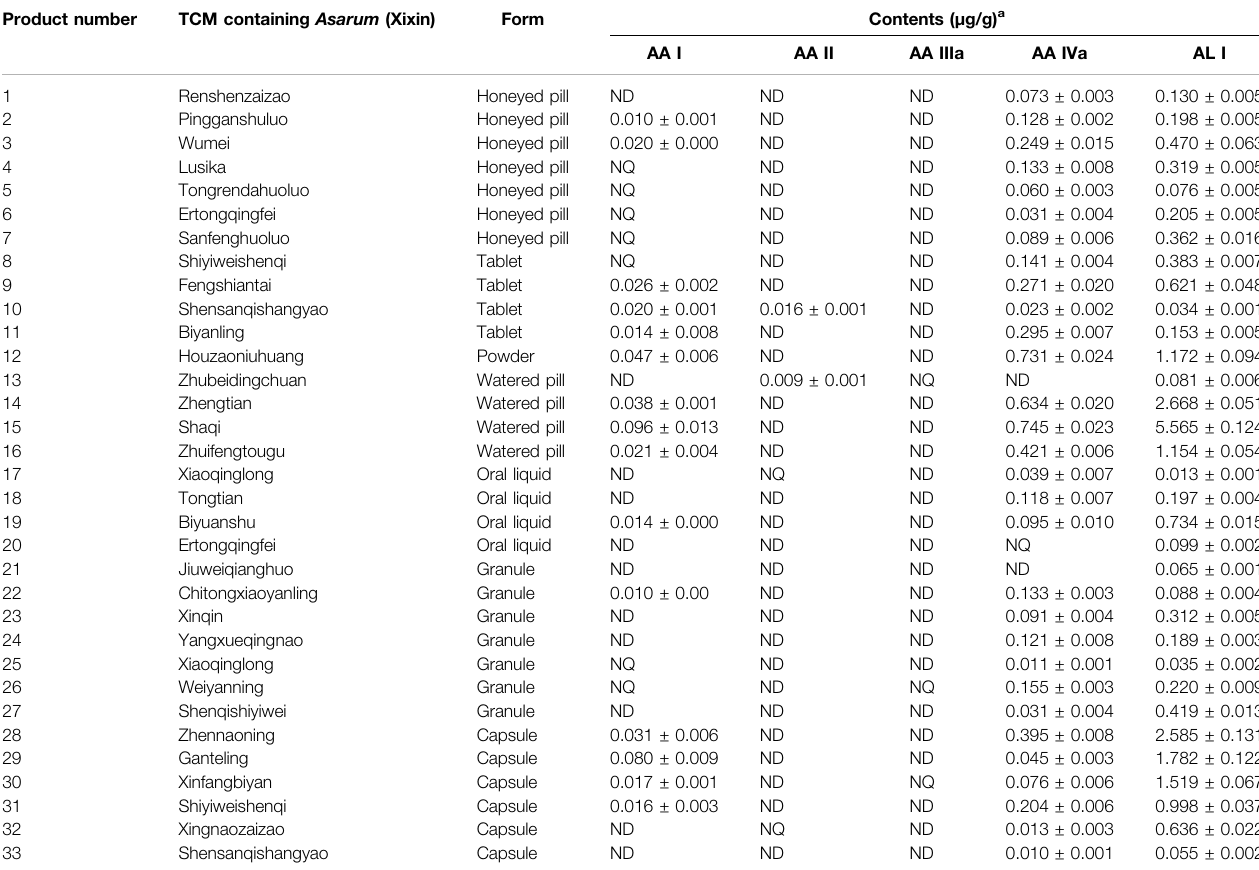
TABLE 2 | Quantitative determination of aristolochic acid analogues in traditional Chinese patent medicines containing Asarum heterotropoides F. Schmidt (Xixin) Product